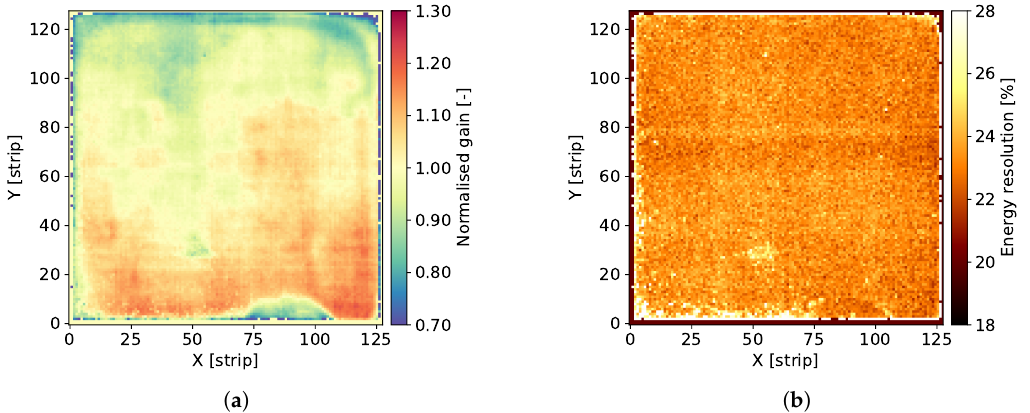
Figure 20. Standard GEM detector E with copper foils. 2D maps of: ( a ) normalized gas gain; and ( b ) energy resolution for detector bias voltage of 3810V.